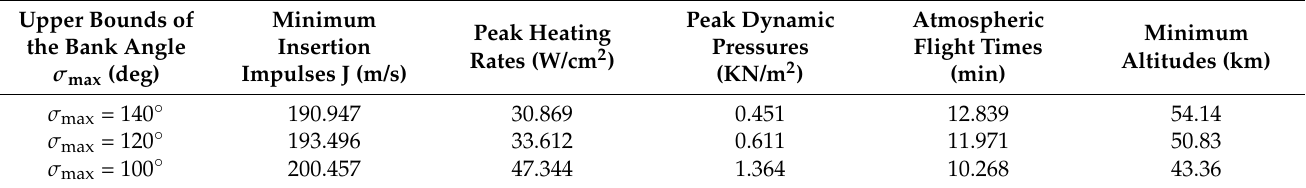
Table 4. Optimal results with different upper bounds in terms of the bank angle.